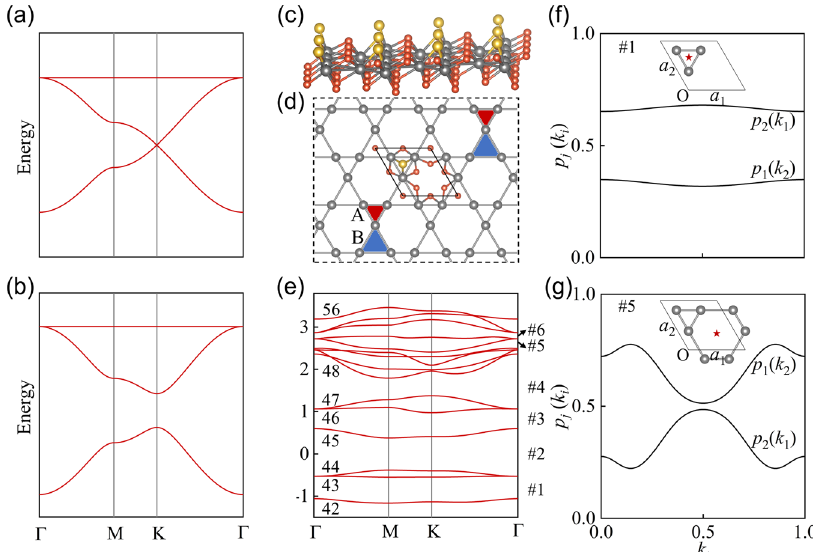
Fig. 1 Bulk topology of ML Nb 3 TeCl 7 . a , b TB bulk band structures of the conventional Kagome lattice and breathing Kagome lattice, respectively. c Atomic structure of ML Nb 3 TeCl 7 . The Nb atoms, Te atoms and Cl atoms are represented by gray, yellow and red spheres, respectively. d The unit cell of ML Nb 3 TeCl 7 is indicated by the black rhombus. The Nb atoms form a breathing Kagome lattice indicated by gray bonds. The small triangle (triangle A) and big triangle (triangle B) are indicated by red and blue colors, respectively. e Calculated bulk band structure of ML Nb 3 TeCl 7 . The Fermi energy is shifted to zero Energy. f Calculated p 1 k 2 ð Þ ; p 2 k 1 ð Þ½ (cid:4) for Gap #1. Inset: schematic illustration (cid:1) (cid:3) ; 2 of the position of the Wannier center p 1 ; p 2 ð Þ ¼ 1 . g Calculated p 1 k 2 ð Þ ; p 2 k 1 ð Þ½ (cid:4) for Gap #5. Inset: schematic illustration of the position of 3 3 the Wannier center p 1 ; p 2 [Supplementary Fig. 1], we fi nd that the fi fteen low-energy bands in energy region − 1.5 eV ~ 3.8 eV are dominated by Nb 4 d orbitals, indicating the d -orbital character of the breathing Kagome lattice. From Fig. 1e, we can see that there are six d - orbital global bulk gaps, as indicated by Gap #1 ~ #6. Form the symmetry aspect, we point out that such global bulk gaps are induced by the inversion symmetry breaking [see detailed discussion in Supplementary Note II]. Noting the d -orbital character of the breathing Kagome crystal, to study its second- order topology, all the d -orbital global bulk gaps should be taken into consideration. To identify the topology of the six global bulk gaps, we will calculate the bulk polarization (Wannier center) of them below.